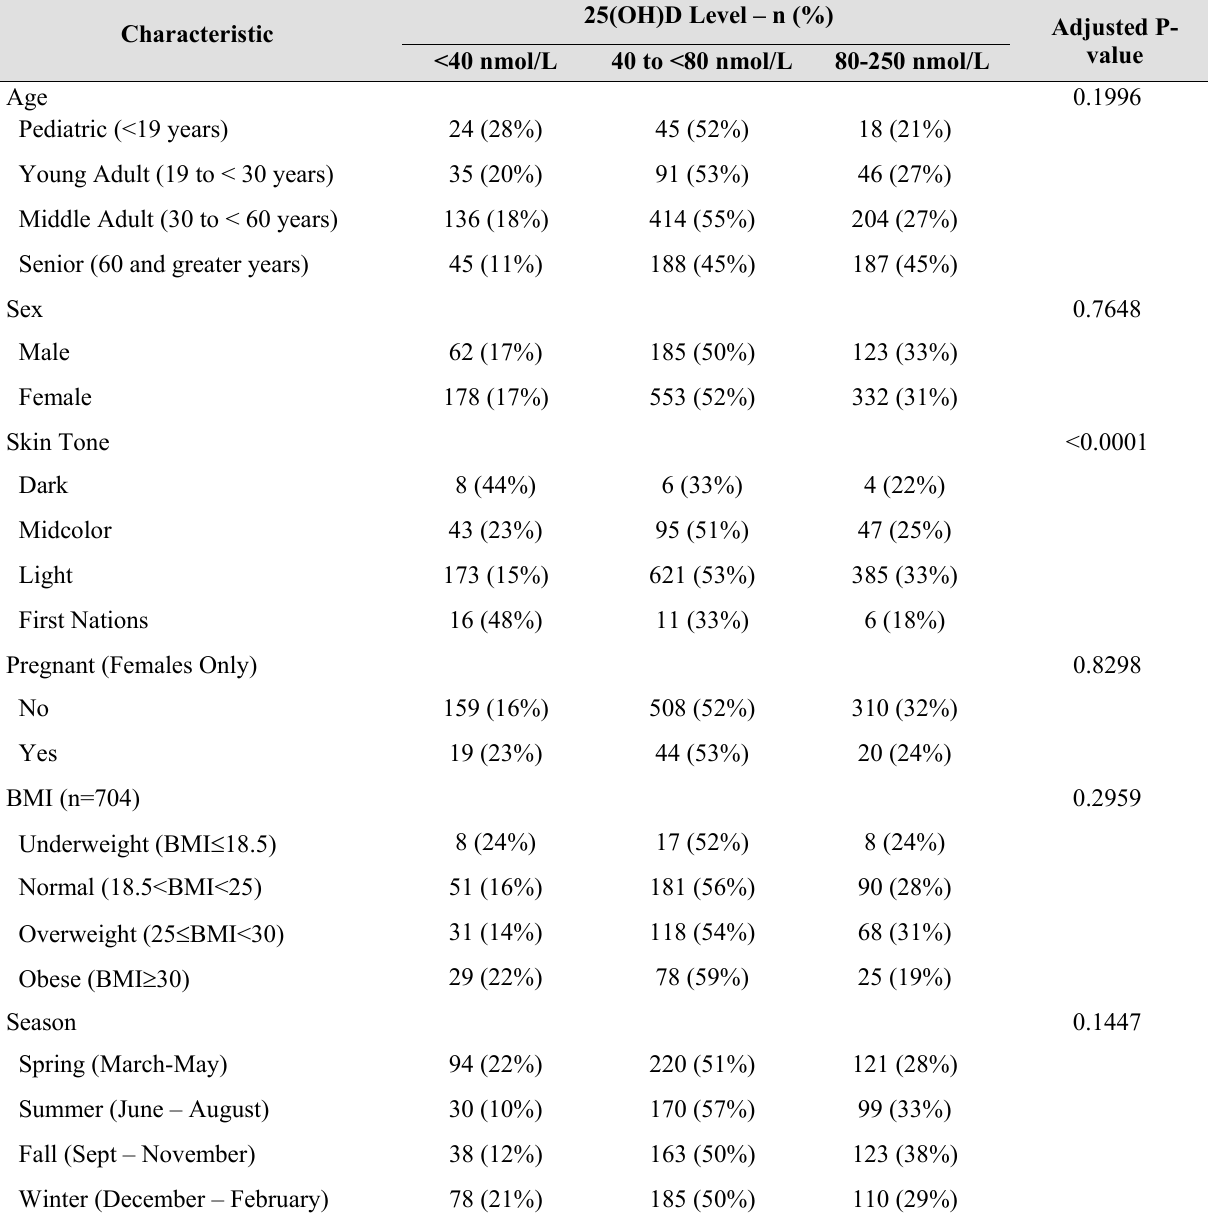
Table 3. Vitamin D Status by Demographic